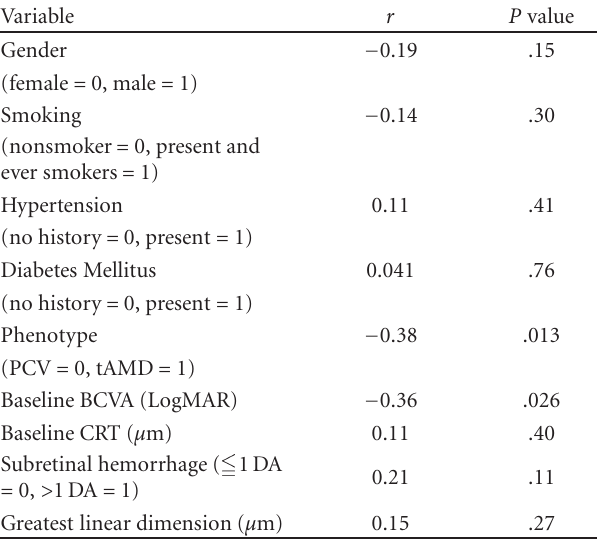
Figure 2: Changes in central retinal thickness (CRT) for tAMD and PCV patients after intravitreal ranibizumab. Diamonds with dashed lines: tAMD; squares with solid lines: PCV. Values represent means ± SEM. Table 4: Multiple regression analysis of preoperative variables with the changes in BCVA between the baseline and 3 months after the initial